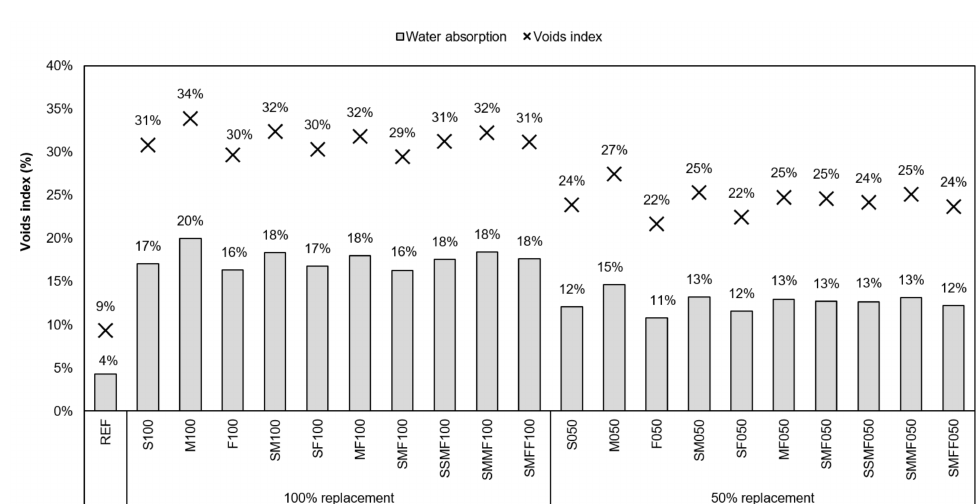
Figure A8. Dry density.